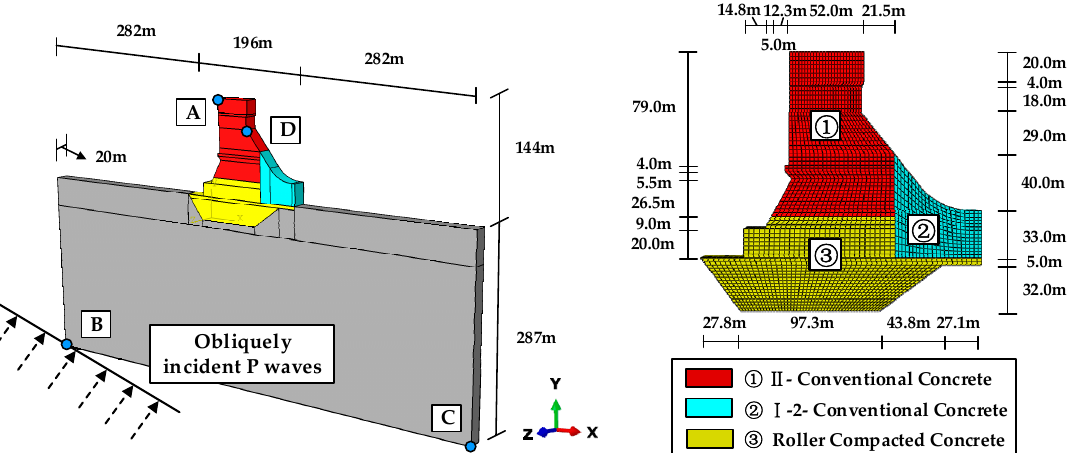
Figure 7. Three-dimensional ( 3D) gravity dam-foundation system finite element model and the partition diagram of dam body material.